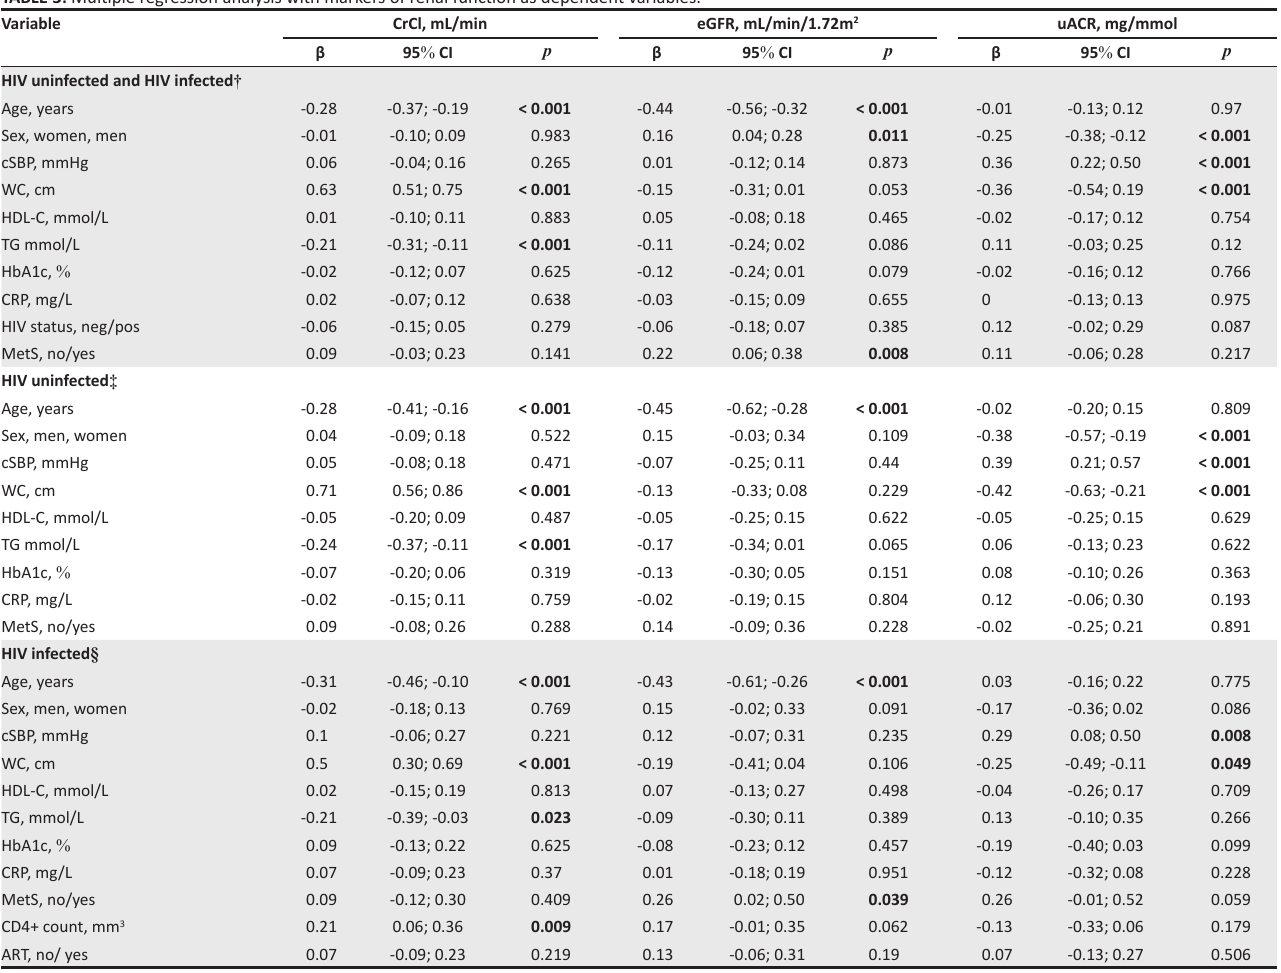
TABLE 3: Multiple regression analysis with markers of renal function as dependent variables.